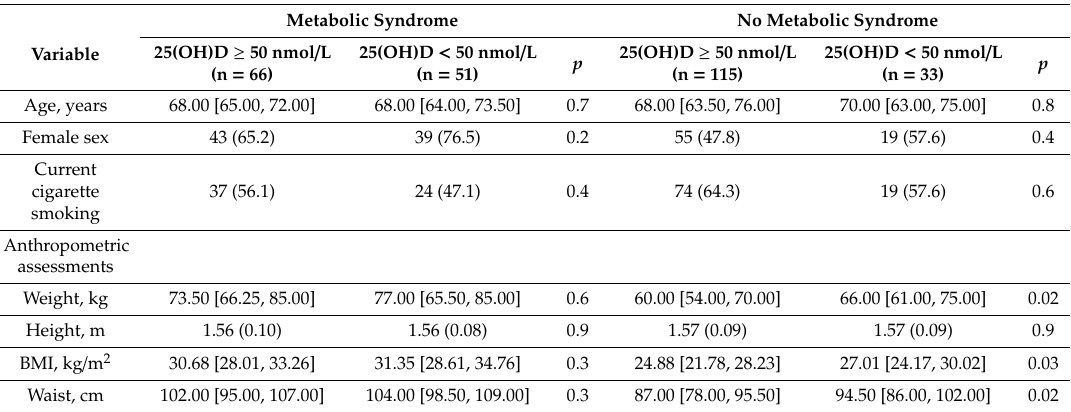
Table 2. Characteristics of subjects with or without metabolic syndrome, according to the vitamin D level (n =